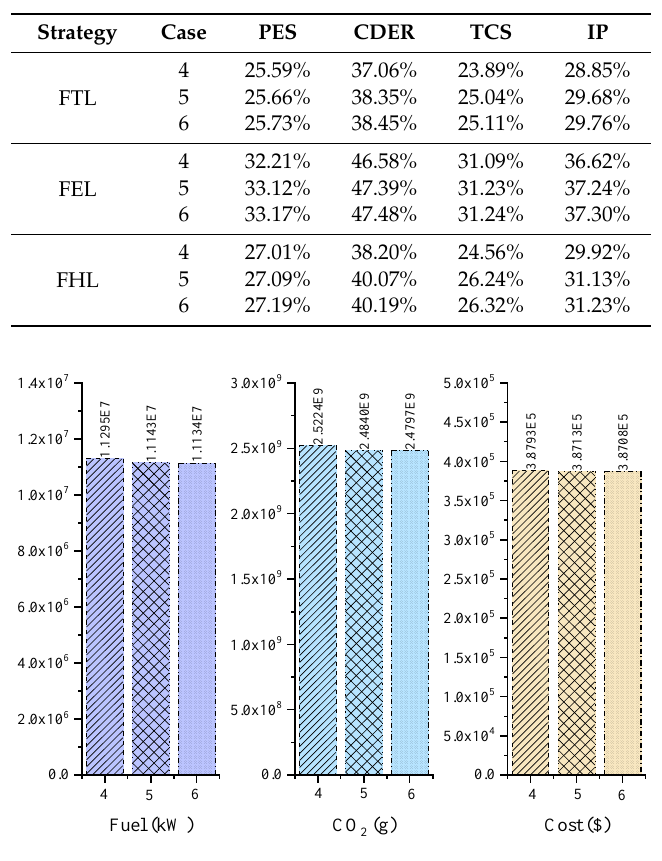
Figure 7. Fuel consumption, CO 2 emission, and cost of the uncertain cases in FEL. Table 6. Optimal design of uncertain cases in FEL.